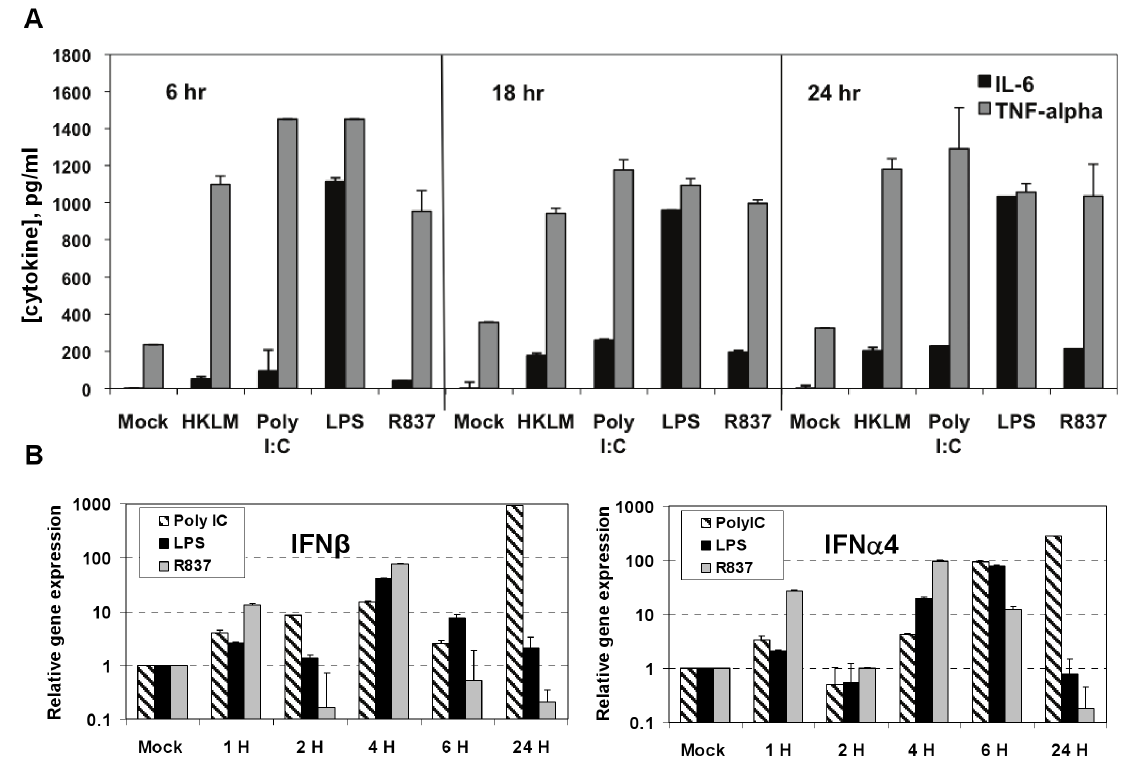
cells. J774A.1 macrophages were stimulated with 10 8 cells/mL HKLM (TLR2), 0.25 μ g/mL poly I:C (TLR3), 5 μ g/mL LPS (TLR4), or 5 μ g/mL imiquimod (R837) (TLR7) for 6